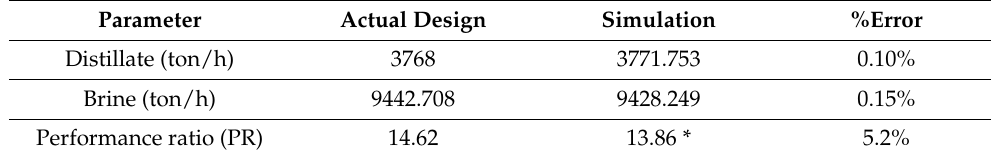
Table 5. Comparison between the actual design of the exiting MED plant and the simulation